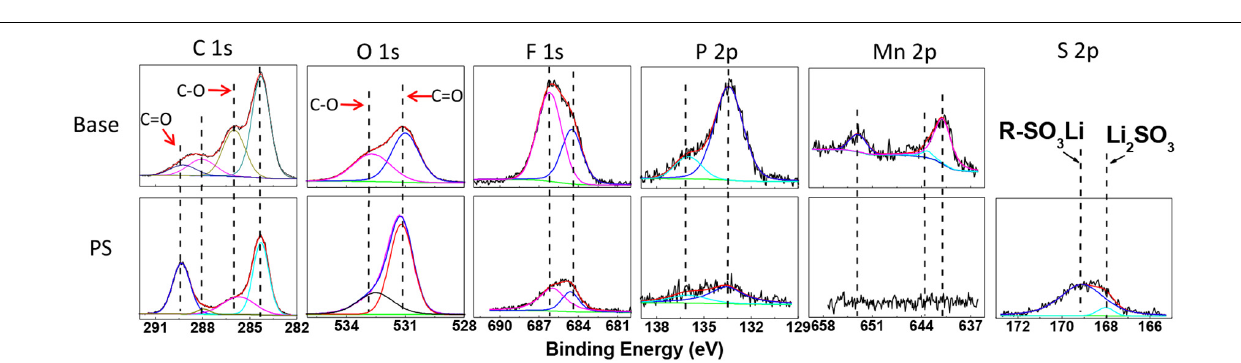
FIGURE 9 | XPS spectra of C 1s, O 1s, F 1s, P 2p, Mn 2p, and S 2p for graphite electrodes after 180 cycles at 60 ◦ C in base electrolyte and PS-containing electrolyte.